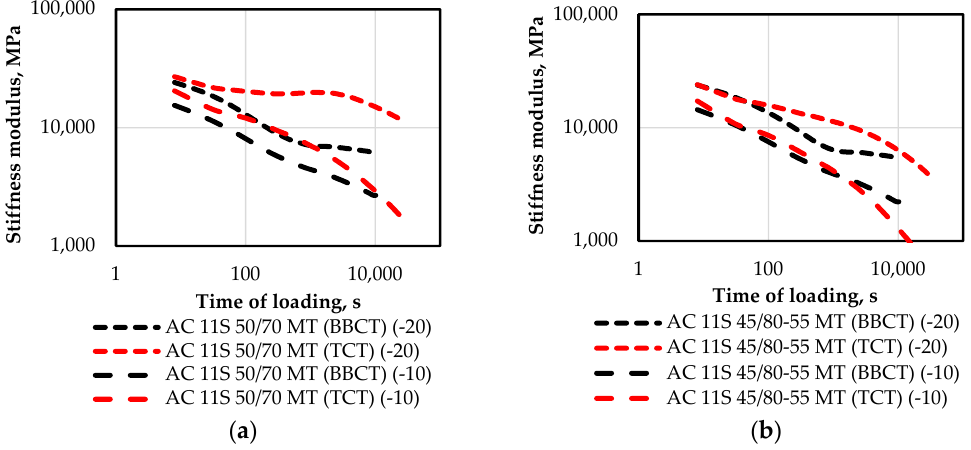
Figure 11. Comparison of stiffness curves at temperatures of − 10 °C and − 20 °C.